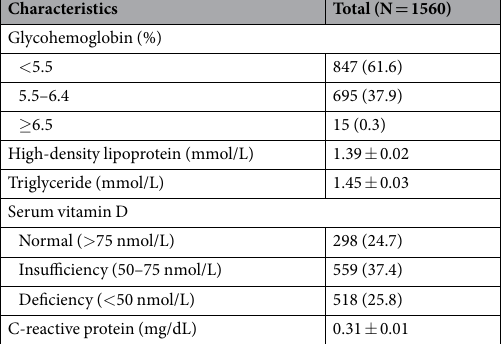
Table 1. Subject characteristics (unweighted N = 1,560; weighted N = 155,402,992). eGFR, estimated glomerular filtration rate. Continuous variables were shown mean ± standard error; categorical variables were shown unweighted counts (weighted %). Numbers may not add to full sample due to missing